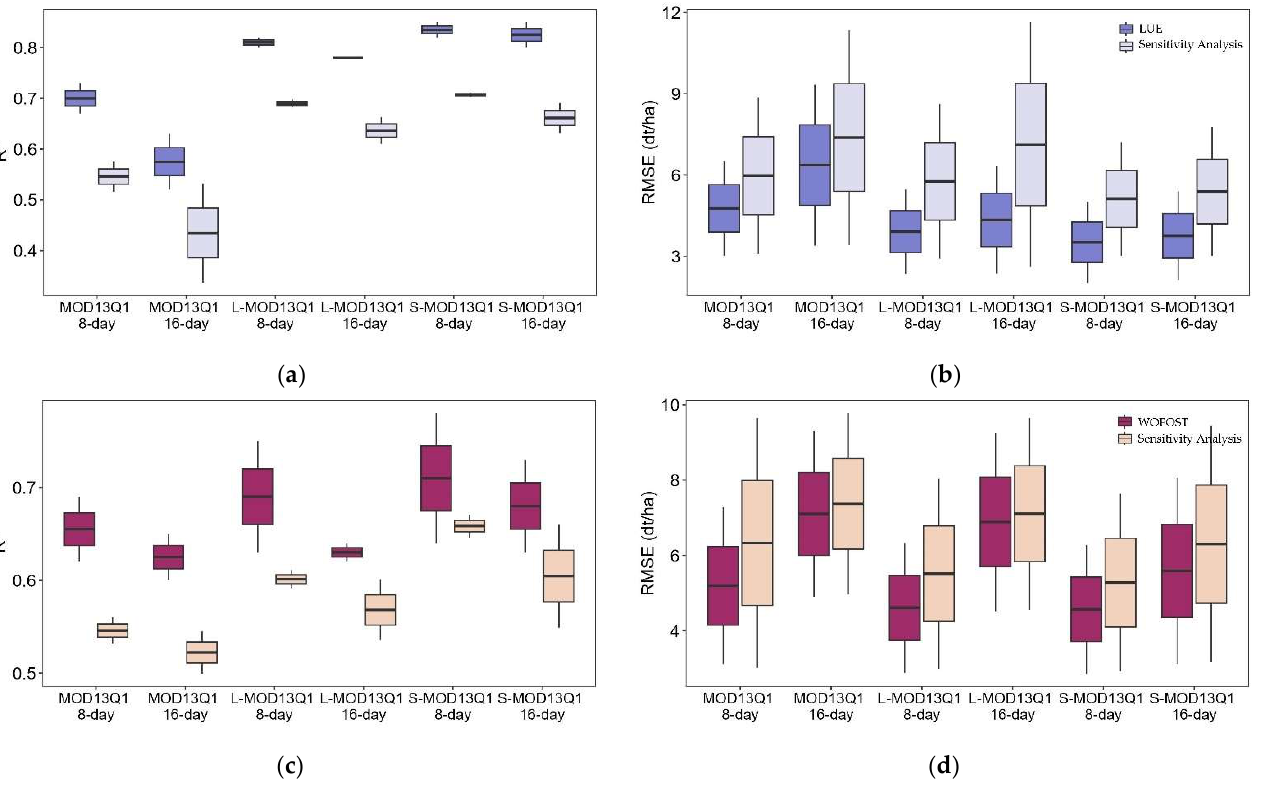
Figure 14. The box plots show the comparison of accuracies ( a , c ) R 2 values and ( b , d ) RMSE values obtained from the referenced yields (at 95% confidence interval), with LUE ( a , b ) and WOFOST ( c , d ) modelled yields including climate stress factors (dark blue and pink) and the modelled yields ex- cluding the climate stress factors (sensitivity analysis) (light blue and pink).